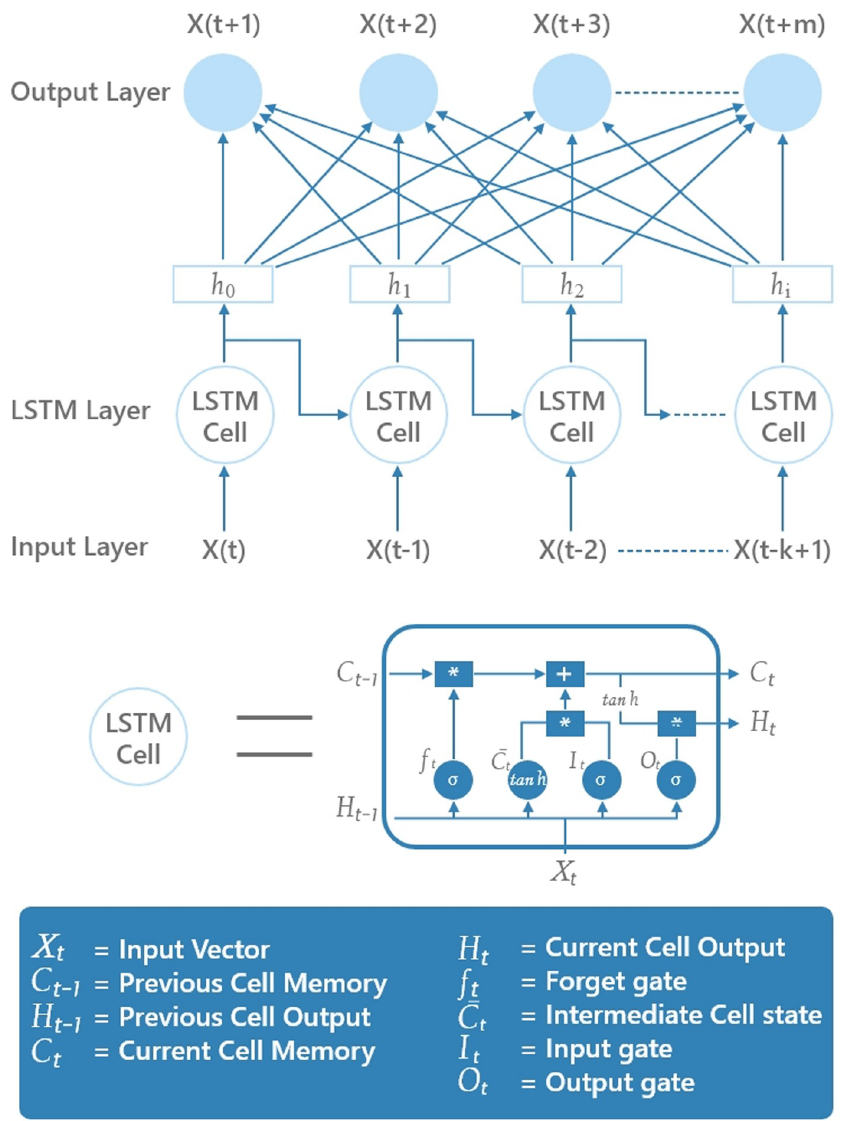
Fig 1. LSTM memory cell in the LSTM recurrent neural